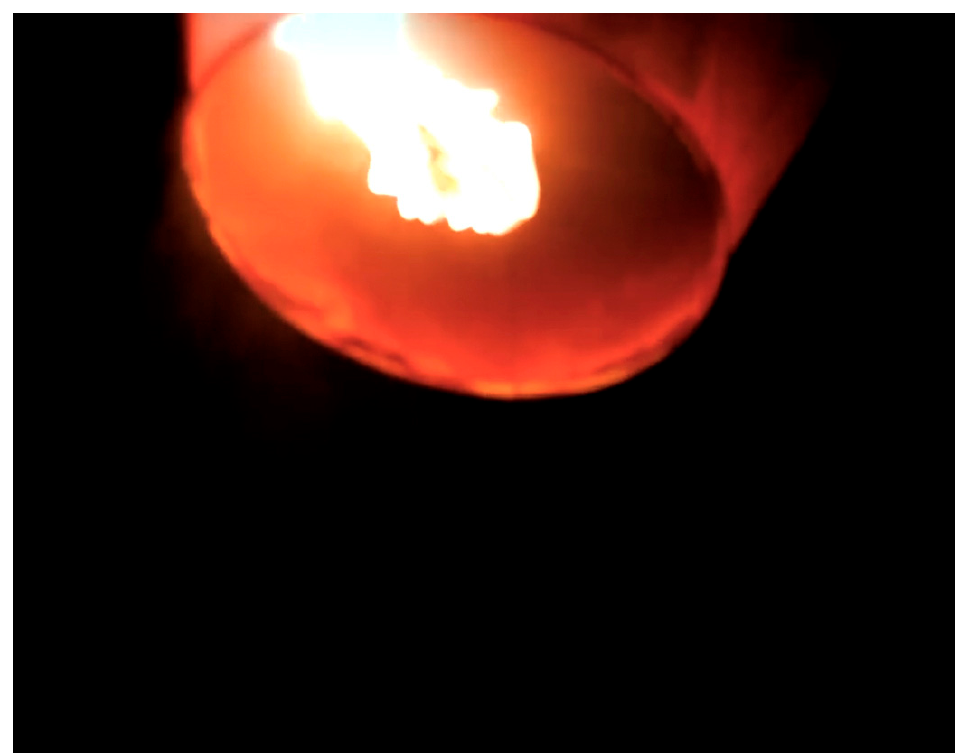
Figure 9. Ye Mimi’s footage of the Wang Yeh boat burning festival in Donggang, Taiwan.